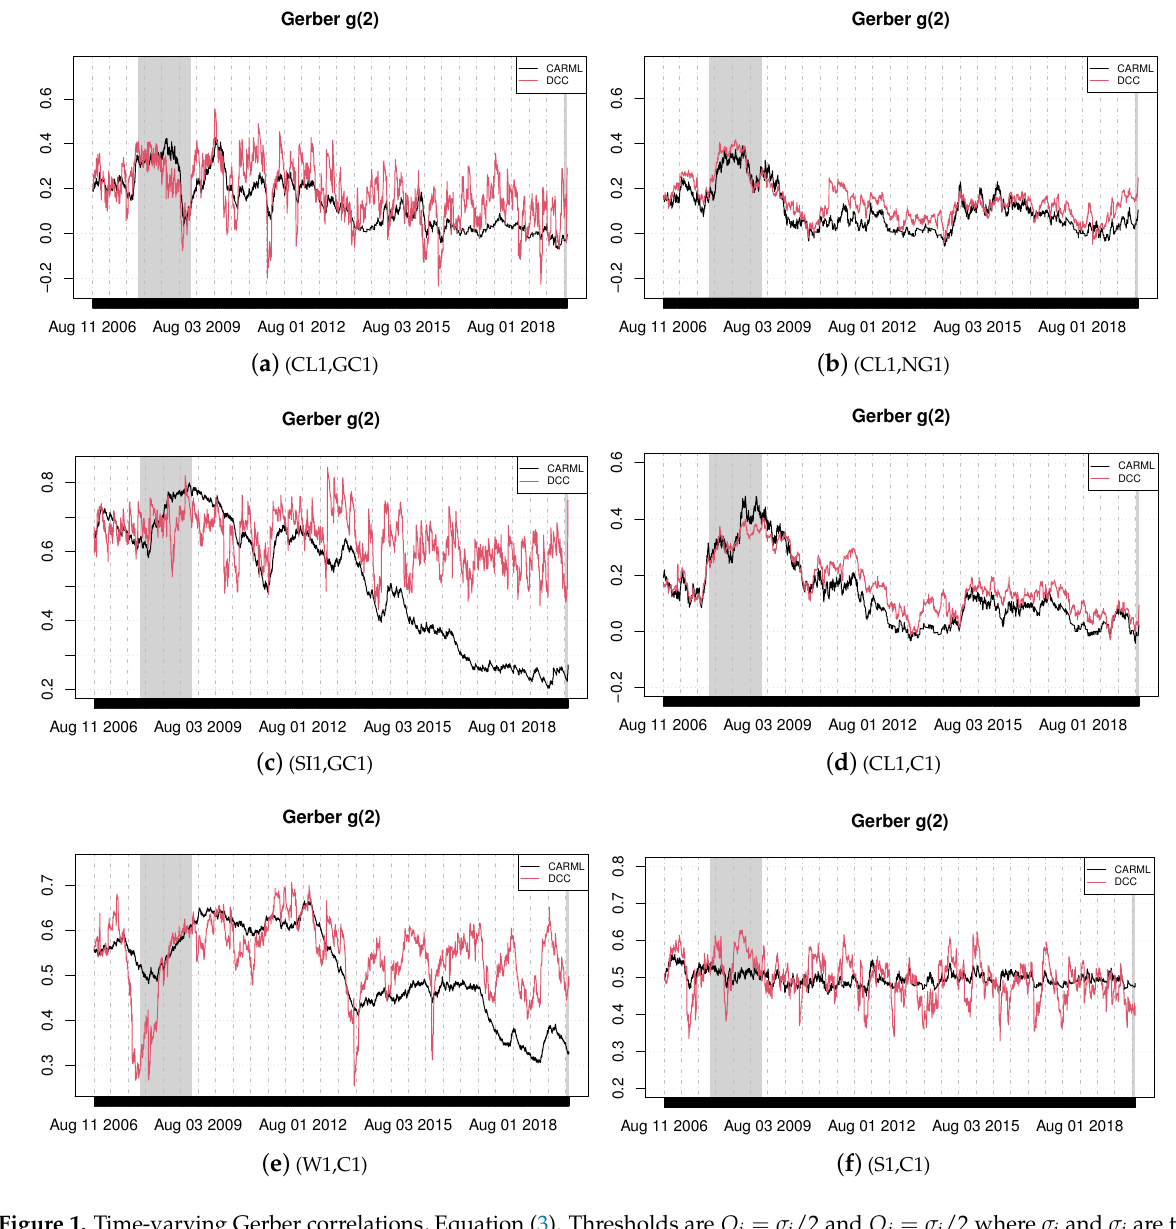
Figure 1. Time-varying Gerber correlations, Equation (3). Thresholds are Q i = σ i /2 and Q j = σ j /2 where σ i and σ j are the (unconditional) return